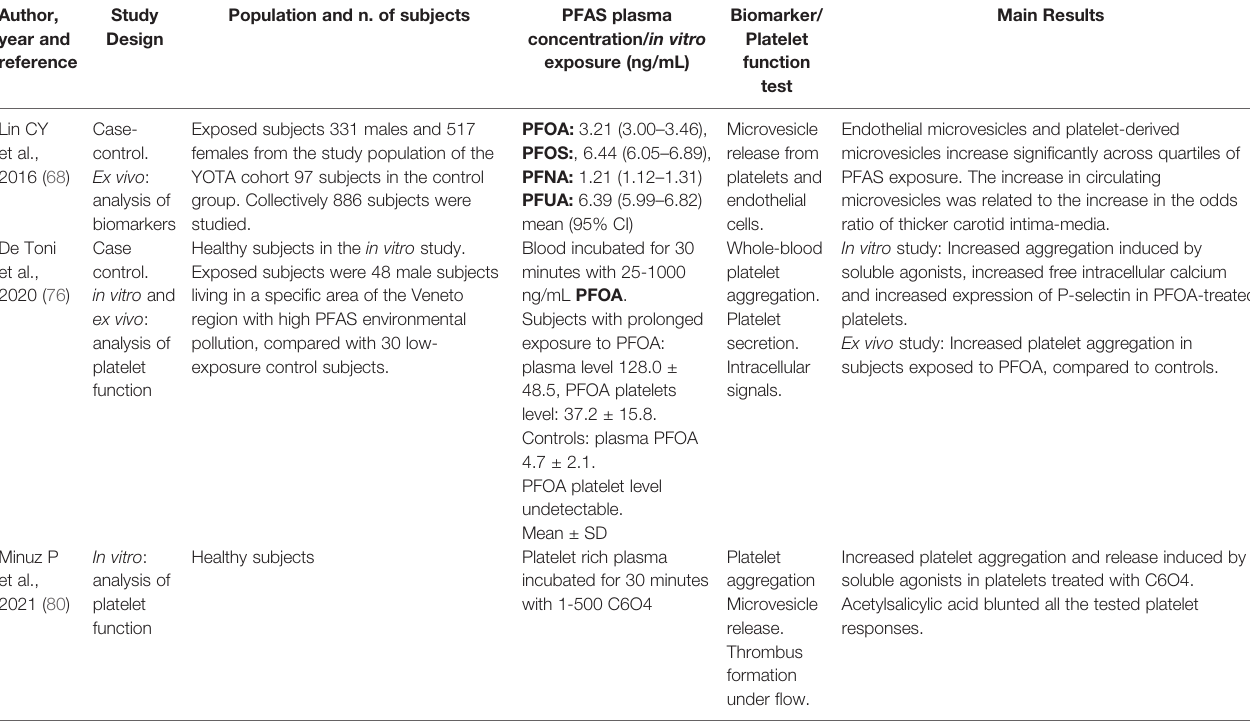
TABLE 3 | Clinical and experimental studies exploring the mechanisms of action of PFAS in platelet and thrombus